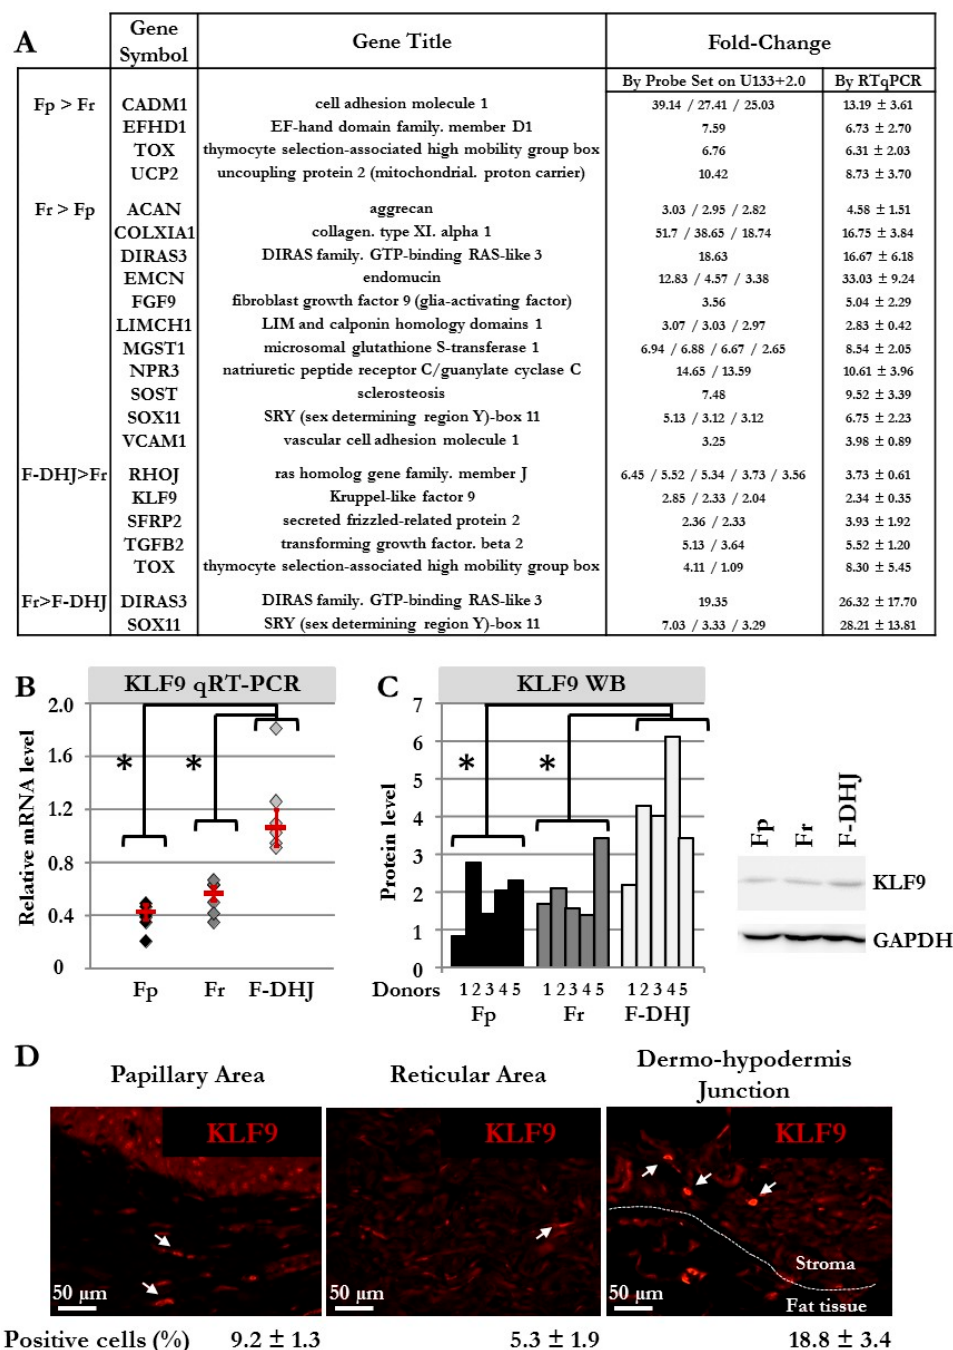
Figure 5. Biomarker validations at mRNA and protein levels. ( A ) Selection of transcripts in which differential expression was confirmed by qRT-PCR in cell samples from 6 donors (donors’ ages: 22, 25, 28, 55, 61, and 65 y.o). ( B ) Detailed qRT-PCR comparative analysis of the KLF9 transcript in cells from the 6 donors (donors’ ages: 22, 25, 28, 55, 61, and 65 y.o). Means ± SEM are indicated (* p < 0.05, Wilcoxon test). ( C ) Western blot comparative analysis of the KLF9 protein in cells from the 5 donors (* p < 0.05, Wilcoxon test). A histogram detailing quantifications and a representative western blot gel is shown. ( D ) Immunofluorescence detection of the KLF9 protein in skin sections (breast). The percentage of KLF9 + cells was determined by observation under a fluorescence microscope of a total of 806 cells for Fp, 289 cells for Fr, and 246 cells for F-DHJ fibroblasts (skin sections from 4 donors were included in the analysis).